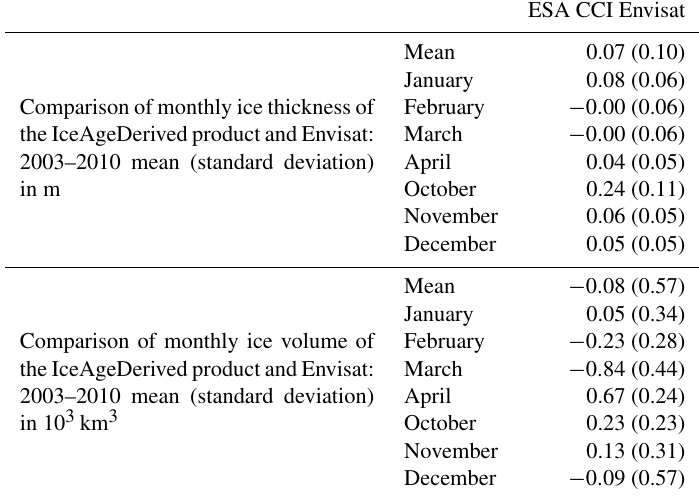
ESA CCI Envisat